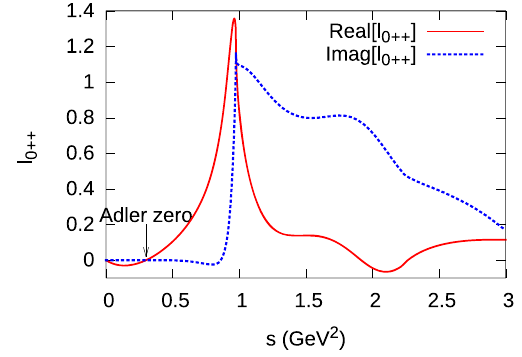
Fig. 3 The S -wave amplitude l 0 ++ from the dispersive construction using the central values of the fitted